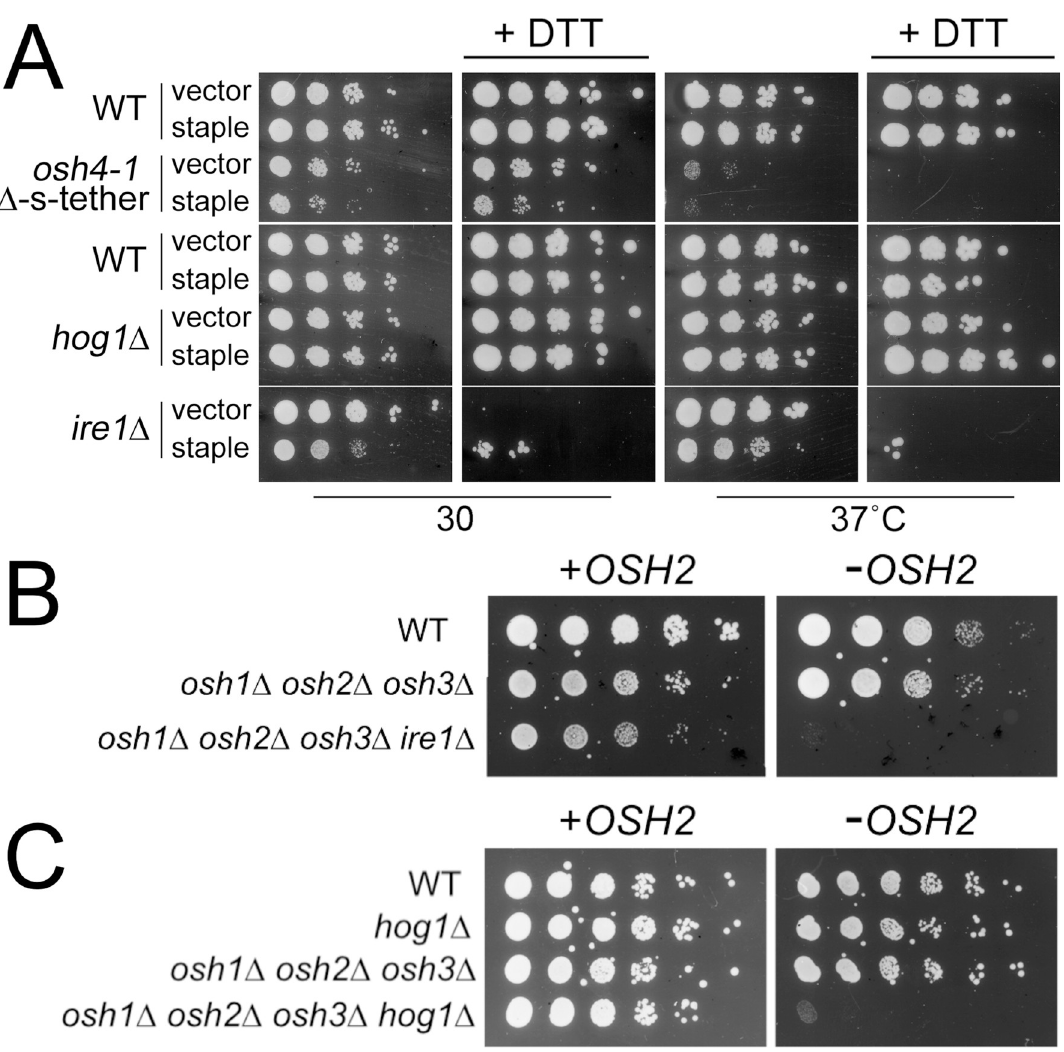
Fig 11. The “artificial ER-PM staple” rescues UPR inactivation, and deletion of HOG1 or IRE1 is synthetically lethal with osh1 Δ osh2 Δ osh3 Δ . ( A) Tenfold serial dilutions of osh4-1 ts Δ -s-tether cells with its congenic WT (SEY6210) control, and hog1 Δ and ire1 Δ with their congenic WT (BY4741) control, expressing either the “artificial membrane staple” (pCB1185) or the vector control (YCplac111). Cells were grown at 30˚C or 37˚C on synthetic medium with or without 4 mM DTT for 3 or 5 days, respectively. ( B) Tenfold serial dilutions of WT (SEY6210), osh1 Δ osh2 Δ osh3 Δ (JRY6263), and osh1 Δ osh2 Δ osh3 Δ ire1 Δ (CBY6916) cells containing an episomal copy of OSH2 (+ OSH2 ; pCB113). Cells were spotted onto selective solid medium, or on solid medium containing 5-FAA to select against the OSH2 containing plasmid (- OSH2 ) and grown for 3 days at 30˚C. Removal of the OSH2 plasmid from osh1 Δ osh2 Δ osh3 Δ ire1 Δ cells is lethal. ( C) Tenfold serial dilutions of WT (SEY6210), hog1 Δ (CBY6912), osh1 Δ osh2 Δ osh3 Δ (JRY62563), osh1 Δ osh2 Δ osh3 Δ hog1 Δ (CBY6914) cells that all contain an episomal copy of OSH2 (+ OSH2 ; pCB113). Cells were spotted onto selective solid media, with or without 5-FAA to select against the OSH2 containing plasmid (- OSH2 ) and grown for 4 days at 30˚C. The OSH2 plasmid is necessary for osh1 Δ osh2 Δ osh3 Δ hog1 Δ cells growth indicating that HOG1 deletion in osh1 Δ osh2 Δ osh3 Δ cells is